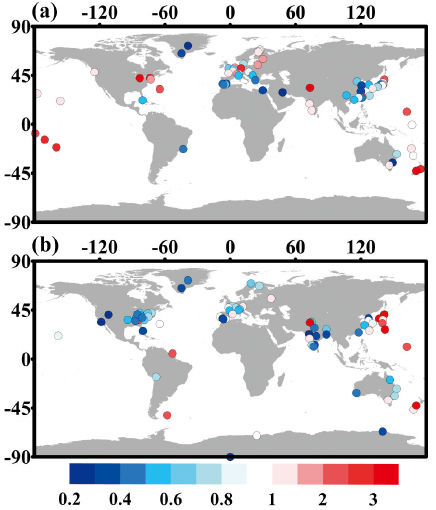
Figure 10. Global distribution of deposition velocities ( V d ) of aerosols (cms − 1 ) obtained from (a) 7 Be and (b) 210 Pb. Note that the color bar below applies to both